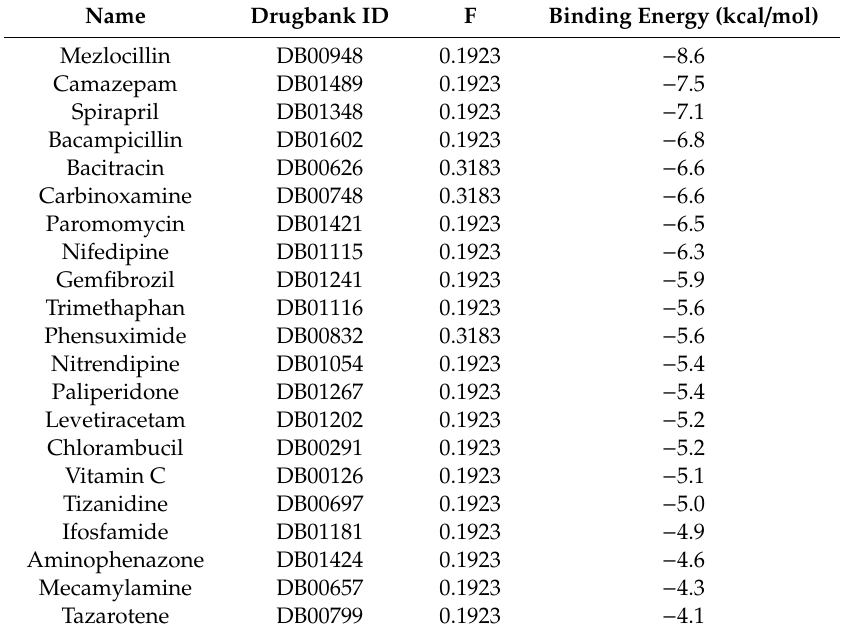
Table 1. Docking scores of the compounds binding to the catalytic site.